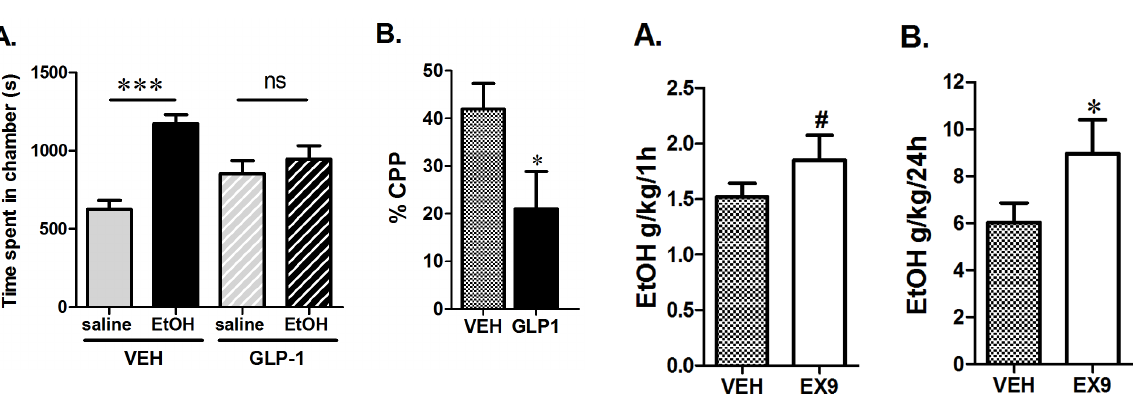
Figure 3. Blockade of GLP-1Rs increases voluntary alcohol intake. Rats (n=12 2 13) peripherally injected with 0.1 mg/kg EX9, a selective GLP-1R antagonist, displayed a tendency for increased consumption of 20% ethanol during the first hour of alcohol exposure (A) that reached significance at the 24 h measurement time-point (B). All values represent mean 6 SEM. # p , 0.1, *p ,